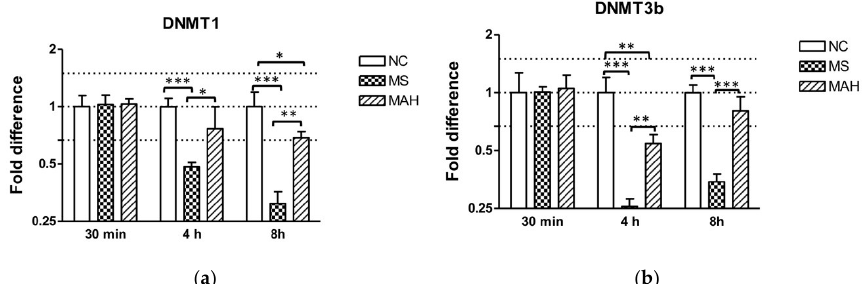
Figure 2. Expression of DNA methyltransferase (DNMT) 1 and 3b in macrophages infected with M. smegmatis (MS, dotted columns) and M. avium subsp. hominissuis (MAH, dashed columns) compared to the negative control (NC, white columns). Dotted lines indicate the fold differences to negative controls (0.67, 1, and 1.5). The area between the outer dotted lines indicates balanced expression between samples and controls. (a) Infection with MS caused a clear downregulation of DNMT1 expression compared to the negative control and to MAH 4 h and 8 h p.i. (b) DNMT3b expression is significantly reduced by MS 4 h p.i. compared to the negative control and compared to infection with MAH. Asterisks summarize p -values (unpaired t -test; * p < 0.05, ** p < 0.01, *** p < 0.001). Columns show means of three biological replicates ( n = 3) and bars show the standard deviation.